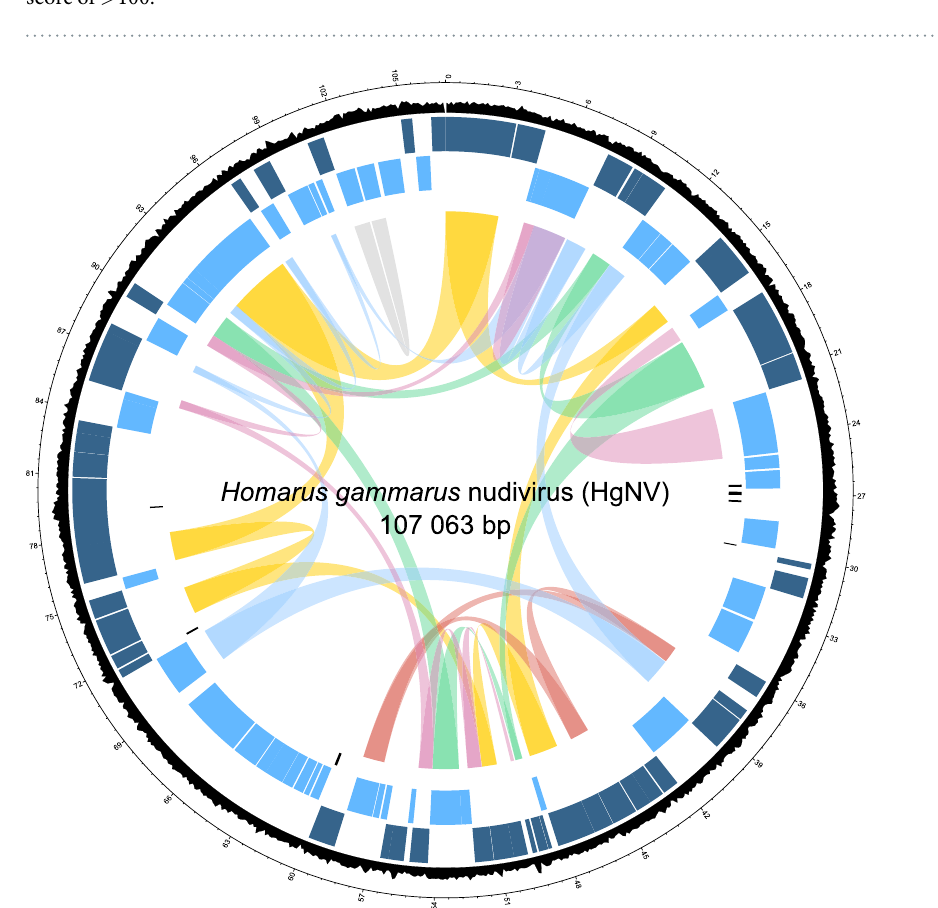
Figure 3. HgNV circular genome plot. Visual representation of HgNV layout scaled to the complete 107 063 bp contiguous sequence. Outermost track shows GC content (%) across complete sequence. Dark blue track displays gene predictions localised to the forward strand, whereas light blue displays those on the reverse. The innermost track depicts direct repeat regions. Links highlight genes involved in similar functions; yellow - DNA replication and repair, red - nucleotide metabolism, green – RNA transcription, pale blue – per os infectivity, pink – packaging and assembly, and grey – apoptosis